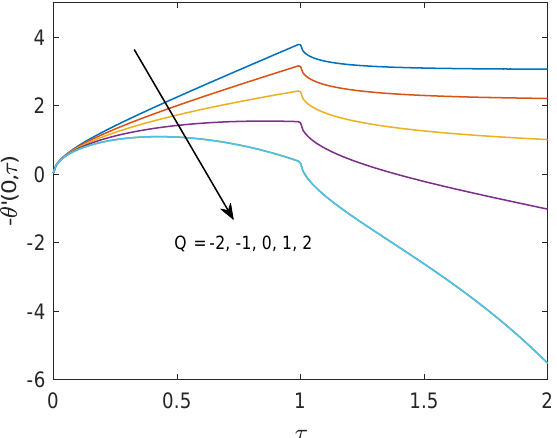
Figure 18. Nusselt number for different values of Q.